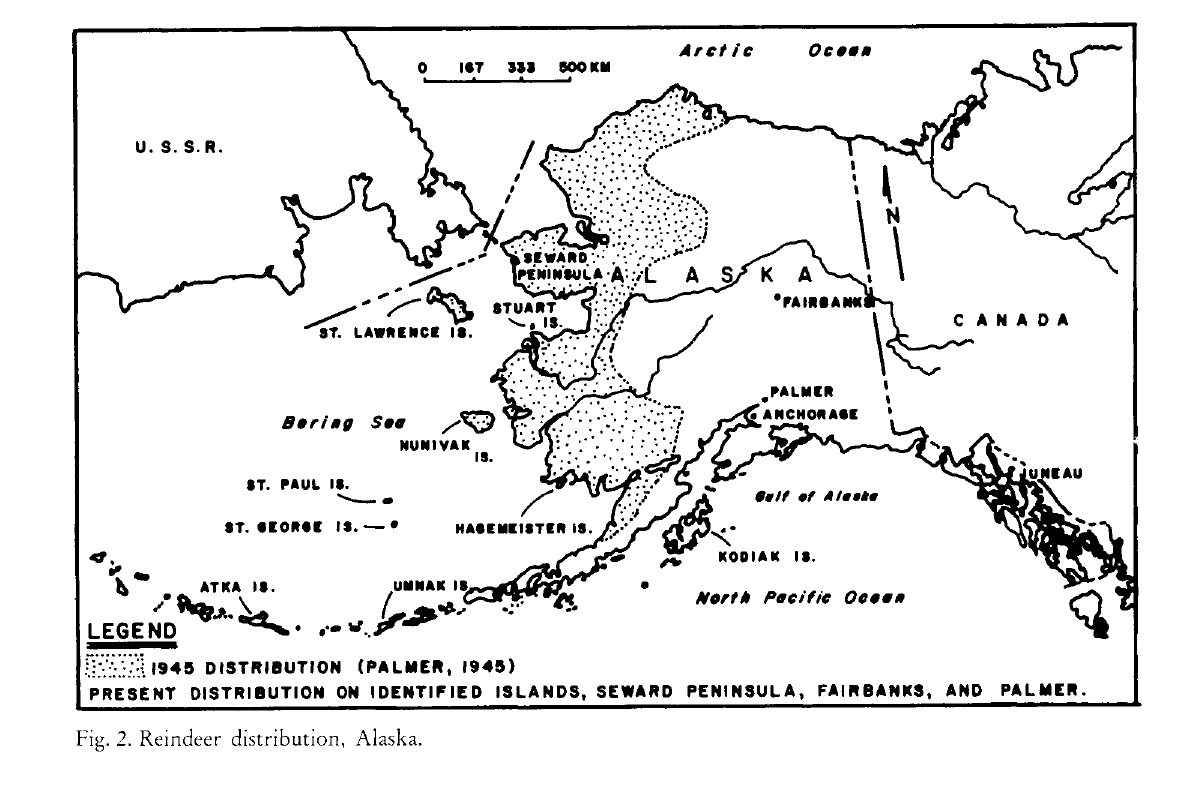
Fig. 2. Reindeer distribution,